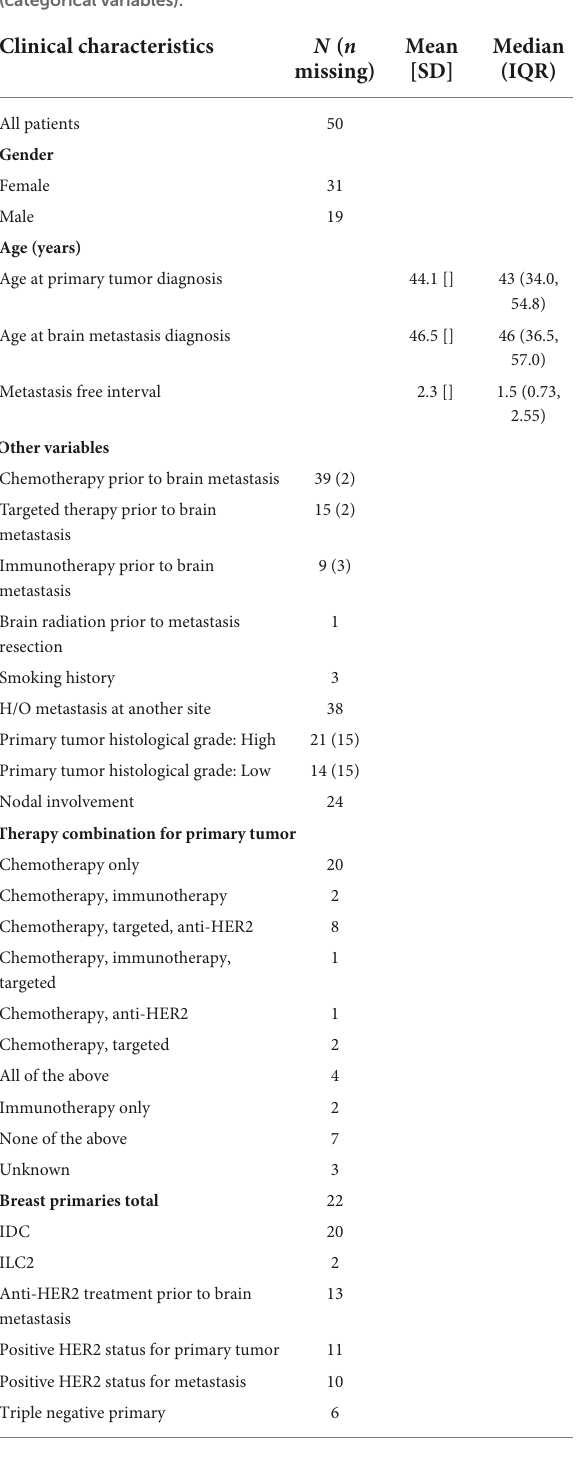
TABLE 1 Patient clinical characteristic summary (categorical